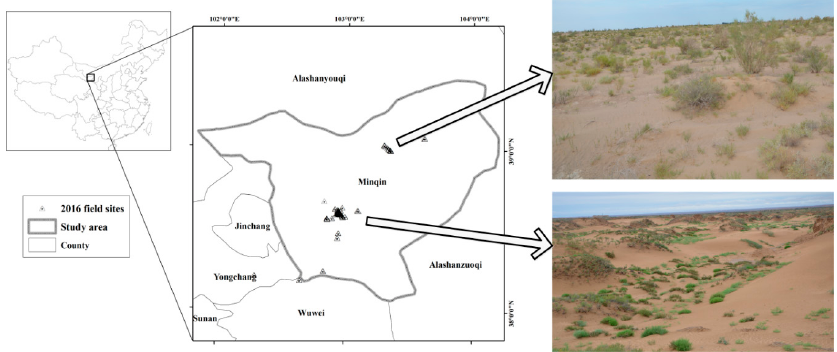
Figure 1. Spatial distribution and pictures of field-observation locations.